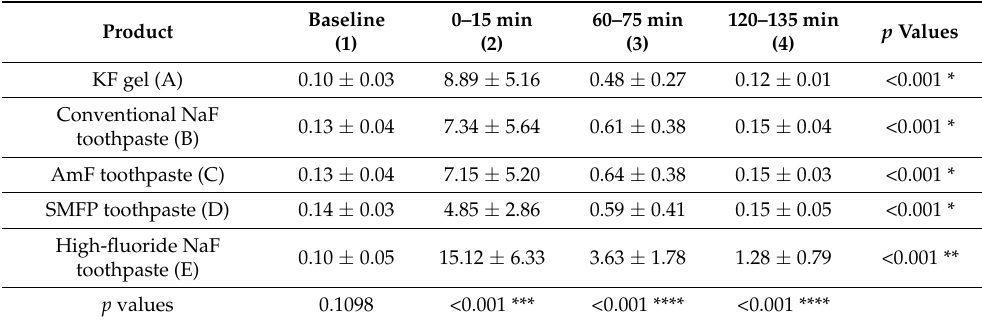
Table 2. Fluoride concentrations [mg/L] in the baseline saliva, immediately after each procedure, 1 h, and 2 h after toothbrushing.